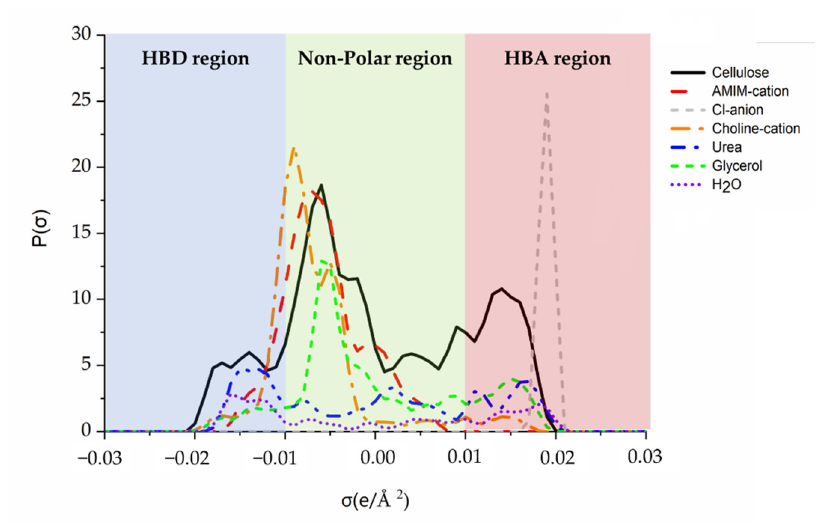
Figure 2. Sigma profiles of cellulose, AMIMCl, urea, glycerol, and choline chloride generated by COSMO.